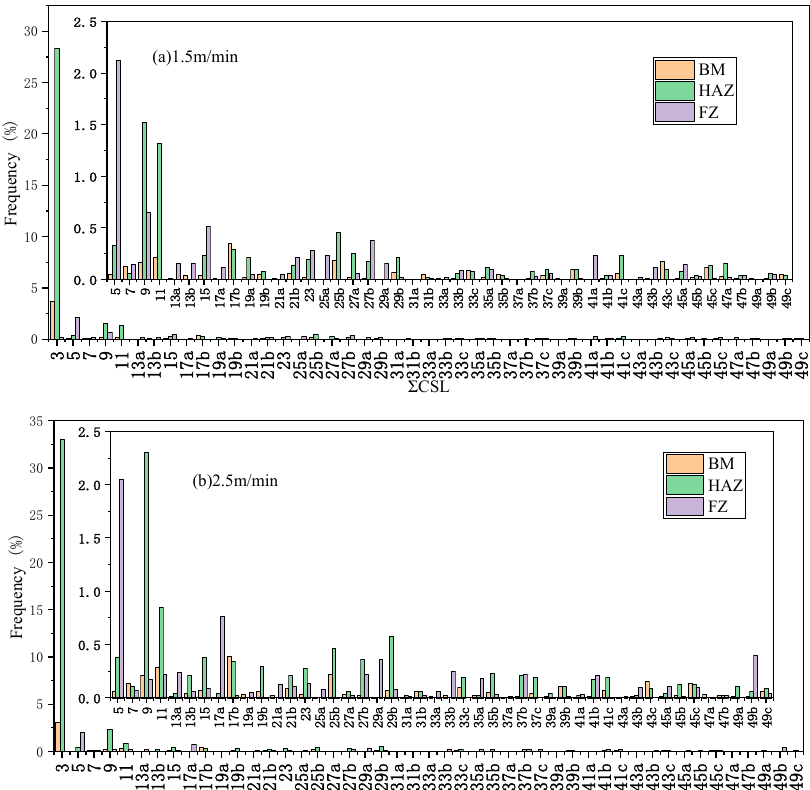
Figure 5. Distribution of Σ CSL boundaries in welded joints: ( a ) 1.5 m/min and ( b ) 2.5 m/min. Table 2. The frequency of Σ 3 n CSL.